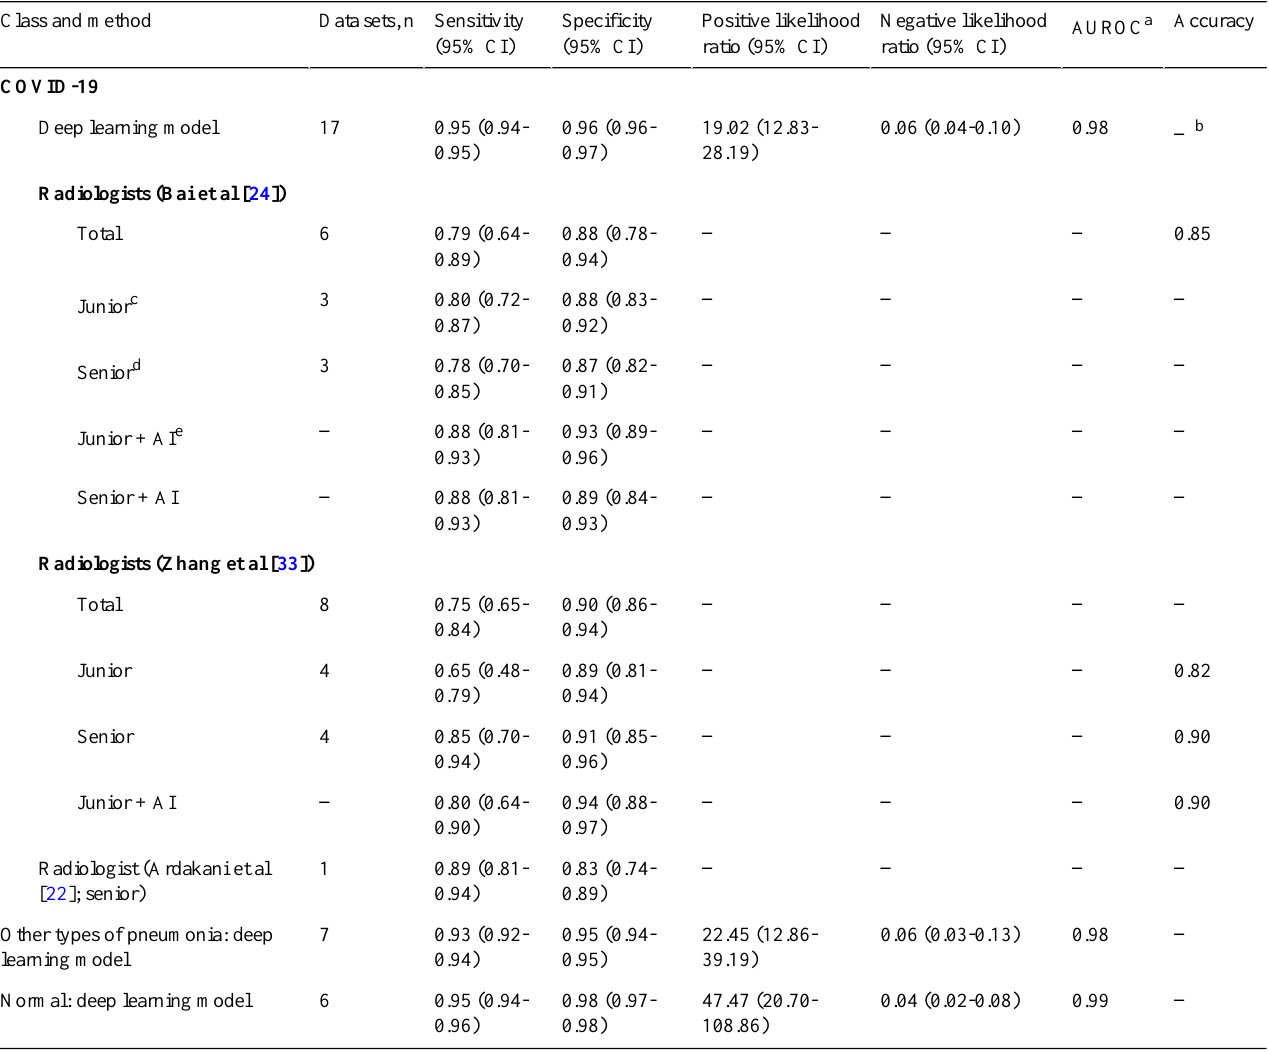
Table 2. Performance comparison between deep learning models and radiologists.